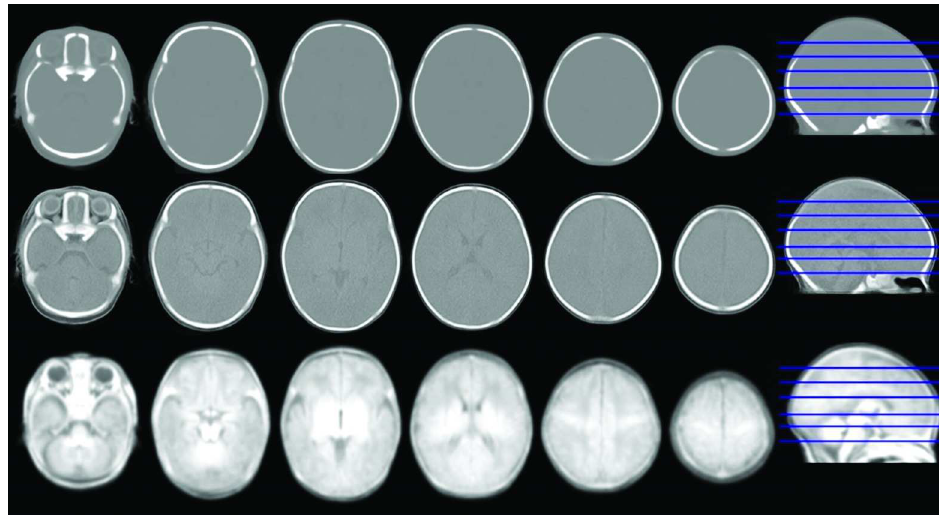
Fig 7. Multi-slice visualization of the proposed neonatal MR-CT head template. The first and second row show some axial slices in Hounsfieldunits and the intensity-transformedscale of GRAMFC_CT 39-42 , respectively, and the third row shows the corresponding slices from the GRAMFC_T 39-42 MR template.